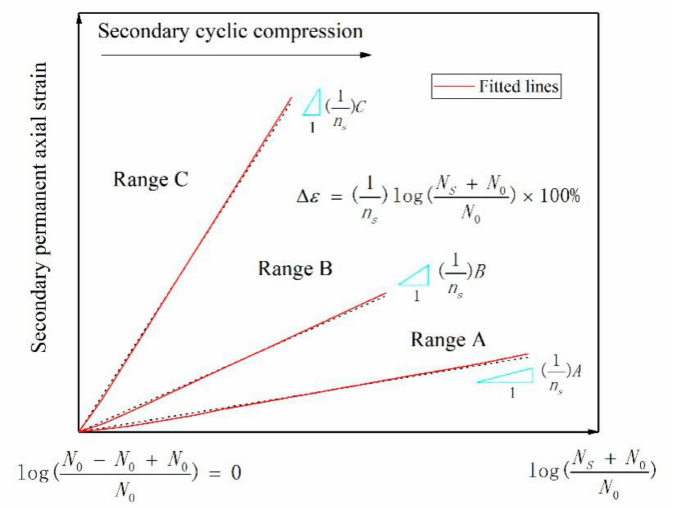
Figure 3. Relationship between cumulative axial strain and rotation number, reprinted with permis- sion from [28]. Copyright 2019 Elsevier.